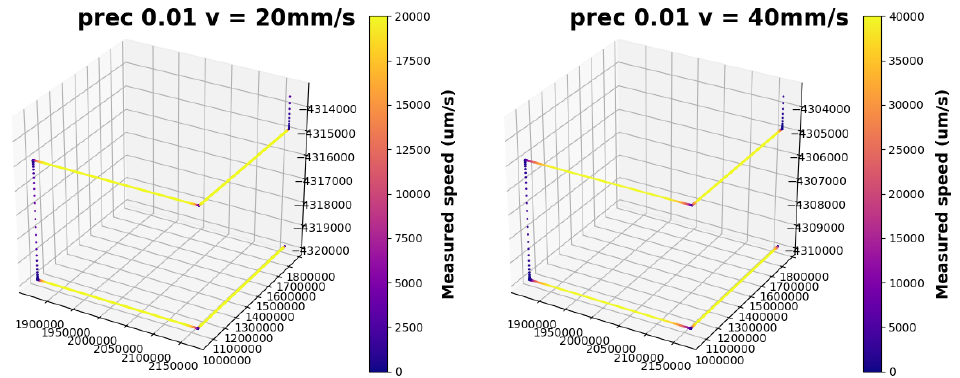
Figure 9. 3D plot of position as a function of velocity (precision e = 0.4) for two successive layers.